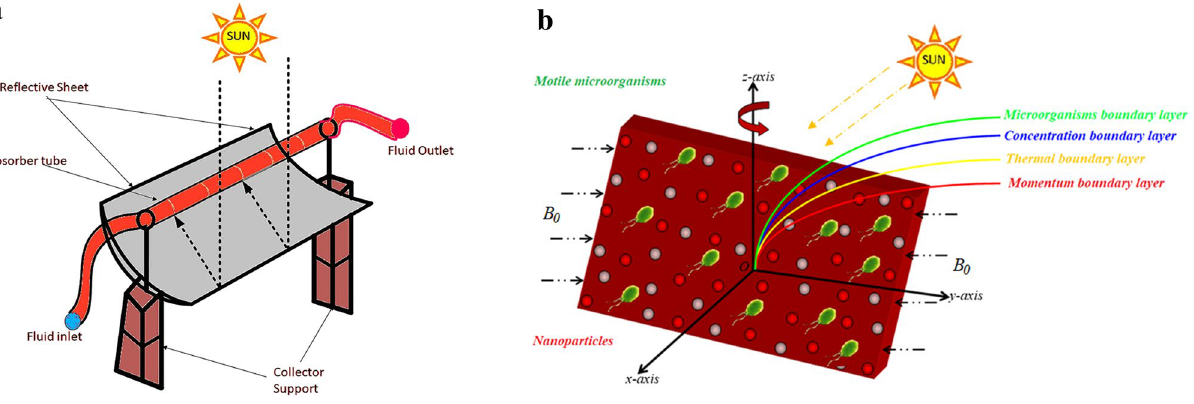
Figure 1. ( a ) Solar effects. ( b ) Physical sketch of the